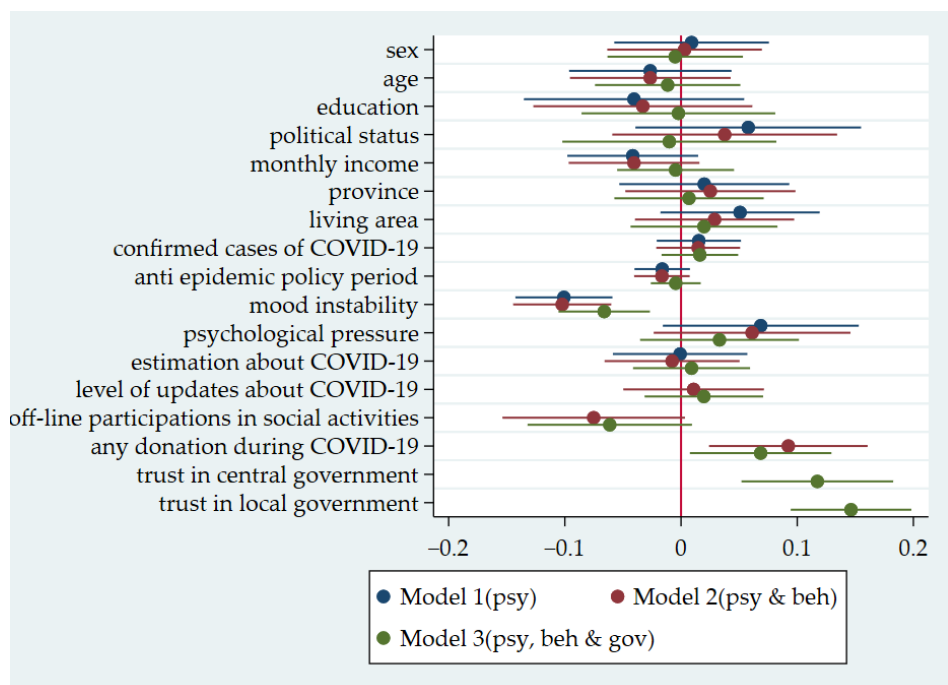
Figure 1. Effects of policy behavior.